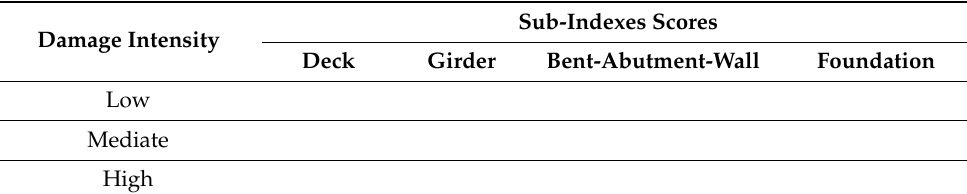
Table A3. Scores of Sub-Indexes in Structural Index. Damage